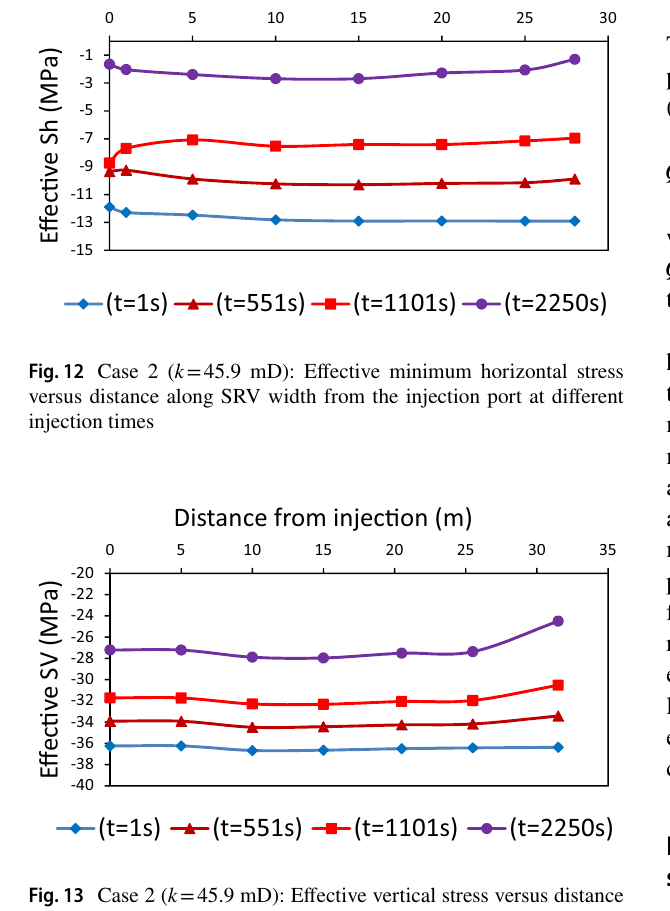
Fig. 14 Pore pressure versus distance using the cubic law equation for a Case 1 and b Case 2. d = fracture aperture in